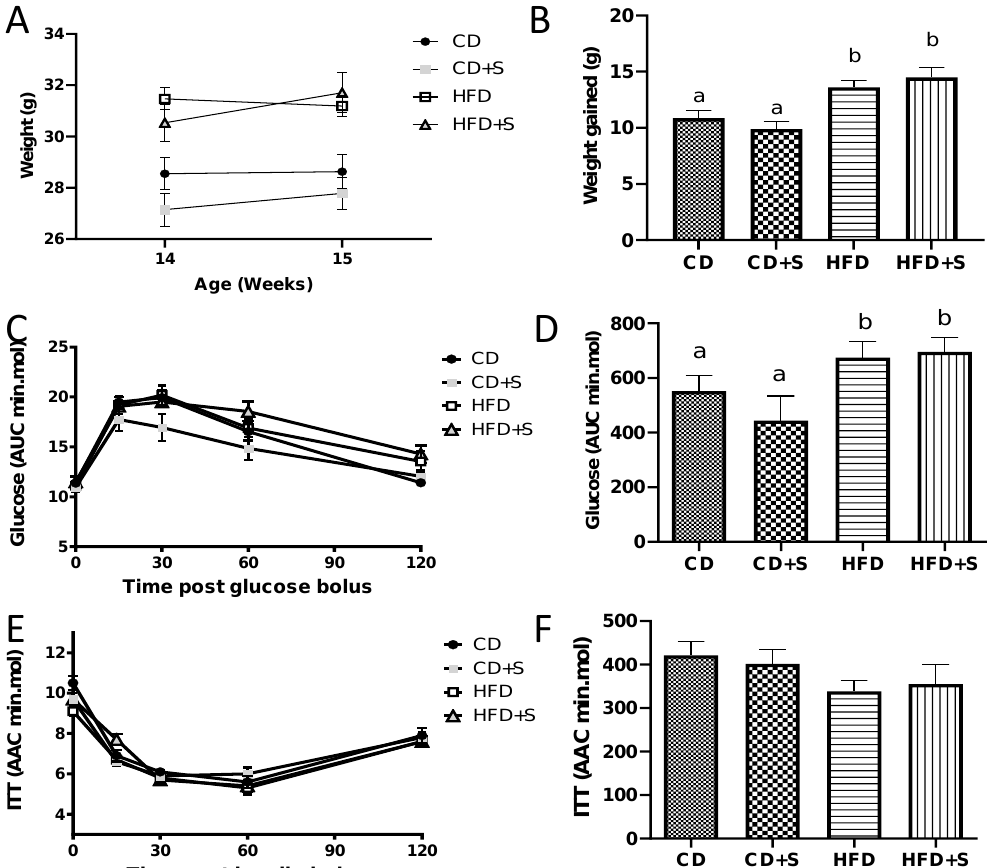
Figure 2. The effect of diet and short-term micronutrient supplementation on body weight and glucose and insulin tolerance during/after treatment phase. ( A ) Weekly weights between weeks 14 and 15; ( B ) total amount of weight gained during both the initial diet and treatment phase; ( C ) glucose tolerance as assessed by glucose tolerance test (GTT, 2g/kg) after treatment phase; ( D ) glucose area under the curve (AUC, min.mmol) during GTT after treatment phase; ( E ) insulin tolerance as assessed by insulin tolerance test (ITT, 1.0 IU) after treatment phase; and ( F ) glucose area above the curve (AAC, min.mol) during ITT after treatment phase. Data is expressed as mean ± SEM. n = 12 males per diet group. CD: control diet, CD + S: control diet plus micronutrient supplementation, HFD: high fat diet, HFD+S: high fat diet plus micronutrient supplementation. Data was analyzed by a repeated measures ANOVA for weight gain or a one way ANOVA for GTT and ITT. Different letters denote significantly distinct groups at p < 0.05.